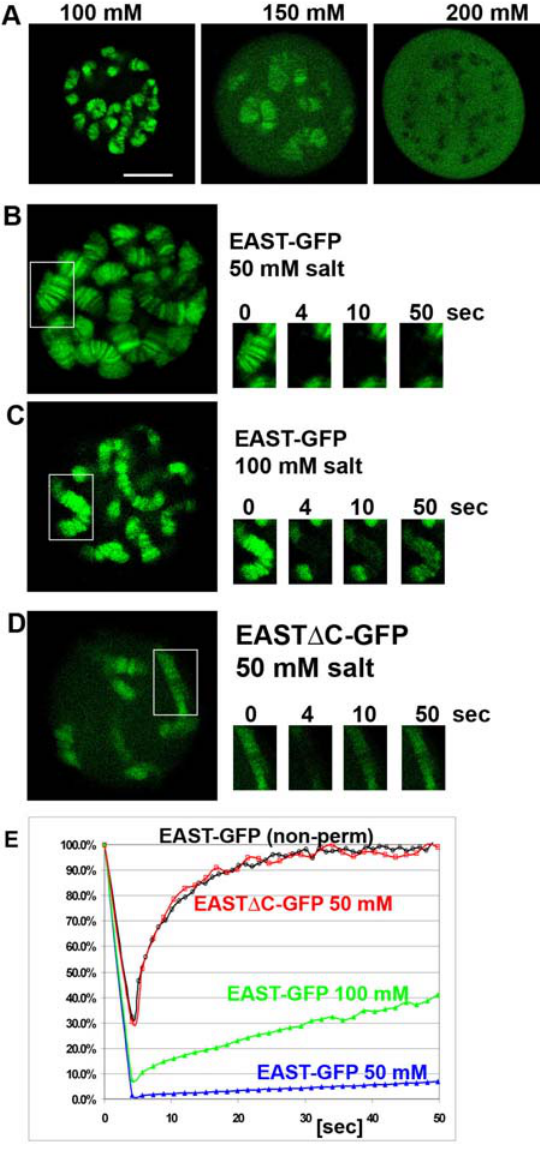
Figure 3. Characterization of EAST-GFP localization and mobility in larval salivary glands. (A) Varying the salt concentration can modulate localization of EAST-GFP. At 100 mM, the distribution is mostly chromosomal, at 150 mM chromosomal and nucleoplasmic and at 200 mM no chromosomal-like pattern is detectable. (B-D) The mobility of EAST-GFP was assessed by FRAP. (B, C) Increasing the salt concentration lowers the affinity to chromatin. An increase in salt from 50 mM (B) to 100 mM (C) leads to a faster recovery of fluorescence after bleaching chromosome regions bound by EAST-GFP. (D) Removing the C-terminal residues 1535-2301 of EAST leads to an increase in mobility. At a salt concentration of 50 mM, the truncated version of EAST associates with a lower affinity than the full-length version. (E) The diagram shows the recovery in seconds after bleaching the indicated nuclear regions for 4 seconds at a laser intensity of 100%. The two different variants of EAST-GFP were expressed using the ftz-GAL4 driver. Cells were permeabilized in buffers containing 50 mM NaCl supple- mented with varying amounts of KCl to reach the indicated salt concentrations. The recovery of the non detergent treated cell (non- perm) in Figure 1A is indicated for comparison. The Bar in A represents 10 m m and applies to all panels.